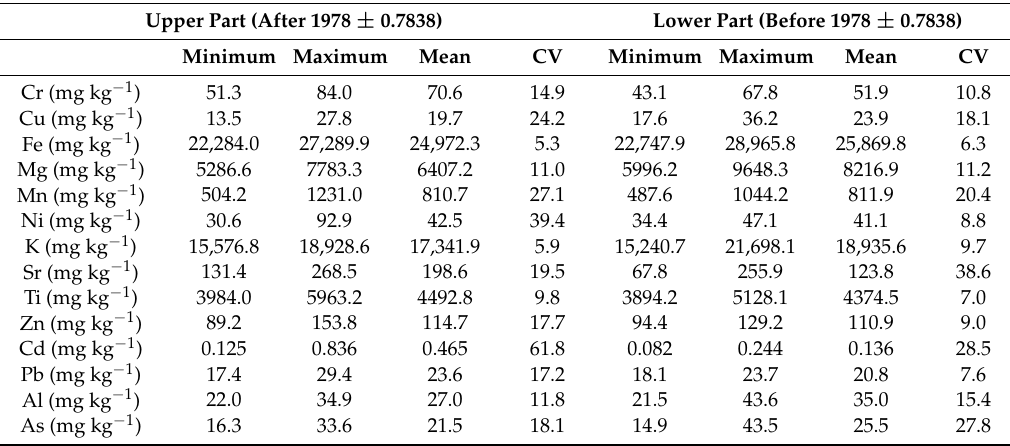
Table 1. Heavy metals in sedimentary columns around 1978 (± 0.7838).